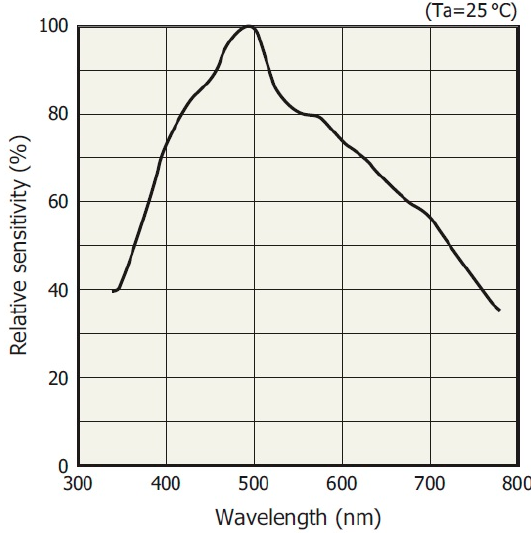
Figure 7. Typical spectral response of the MEMS sensor [23].